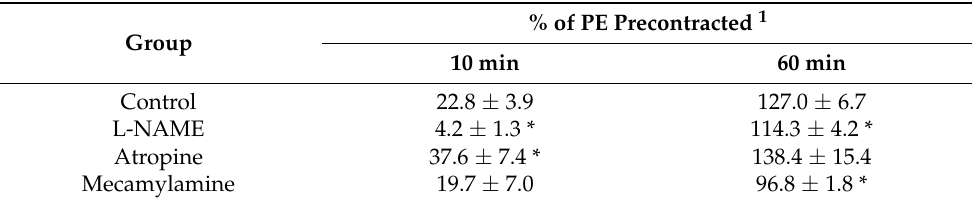
Table 1. Effects of N ω -Nitro-L-arginine methyl ester hydrochloride (L-NAME) on acrylamide- induced relaxation of the endothelium-intact rat aortic ring.